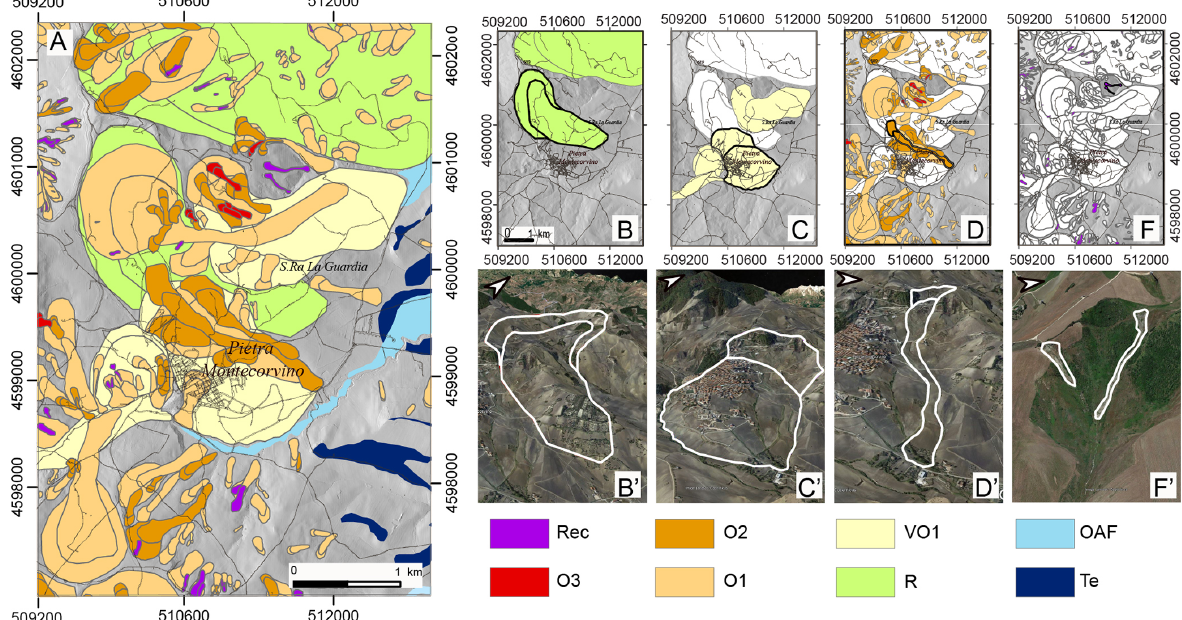
Figure 4. Examples of the relative age classes in the area of the Pietramontecorvino municipality (see Fig. 1 for reference). (a) Detail of the inventory in the selected location. The black-outlined polygon indicates the area in B to I. Very old relict landslides (b) , very old landslides (c) , old landslides (d) and recent landslides (e) are portrayed in detail. Black-outlined polygons in B to E are represented singularly in a perspective view on © GoogleEarth™ in B (cid:48) to F (cid:48) . In the legend: Rec: recent landslides; O1, O2, O3: old landslides of first, second, and third generation; VO1: very old landslides of first generation; R: relict landslides; OAF: old alluvial fan; Te: